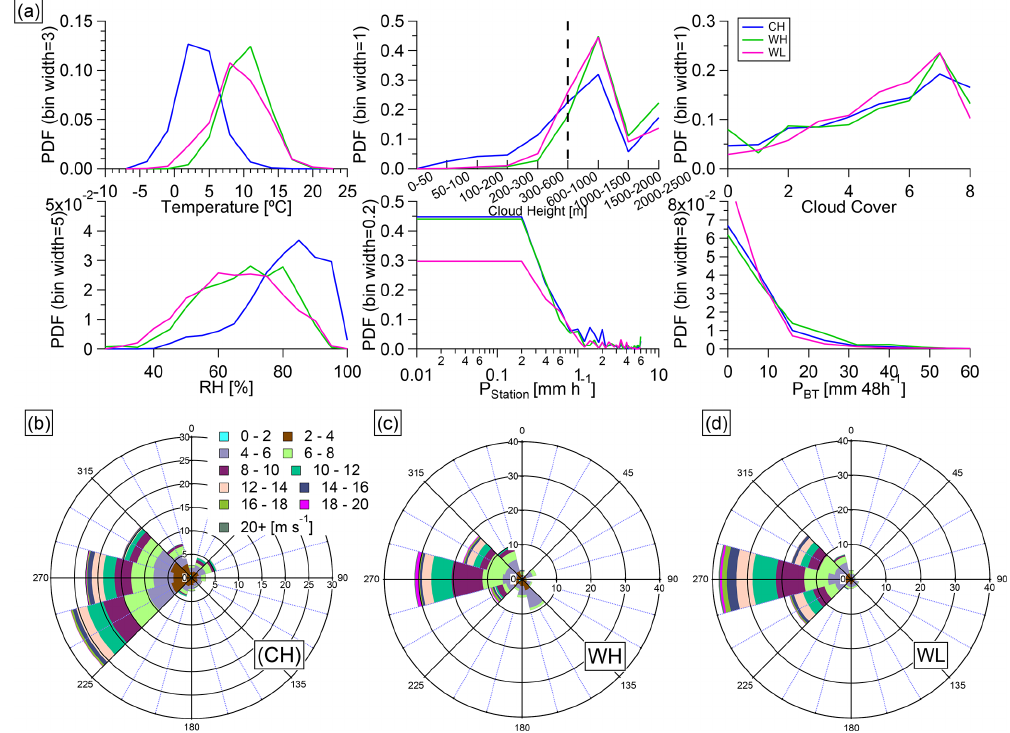
Figure 10. (a) Probability density function (PDF) of temperature, relative humidity (RH), cloud cover, cloud height, precipitation measured at the station ( P Station ), and cumulative precipitation along the backward trajectory in the past 2d ( P BT ) averaged for all samples collected during cold season high (CH, blue lines), warm season high (WH, green lines), and warm season low (WL, magenta lines). (b, c, d) The wind rose plots for CH, WH, and